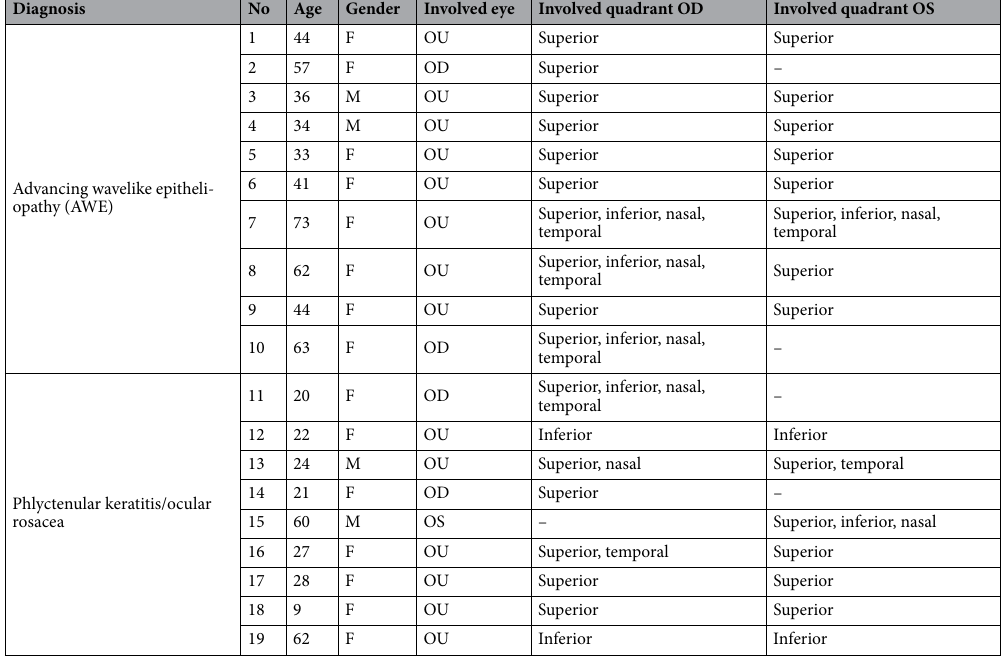
Table 1. Demographic data, disease patterns, and quadrants showing limbal involvement. M male, F female, No case number, OD right eye, OS left eye, OU both eyes.